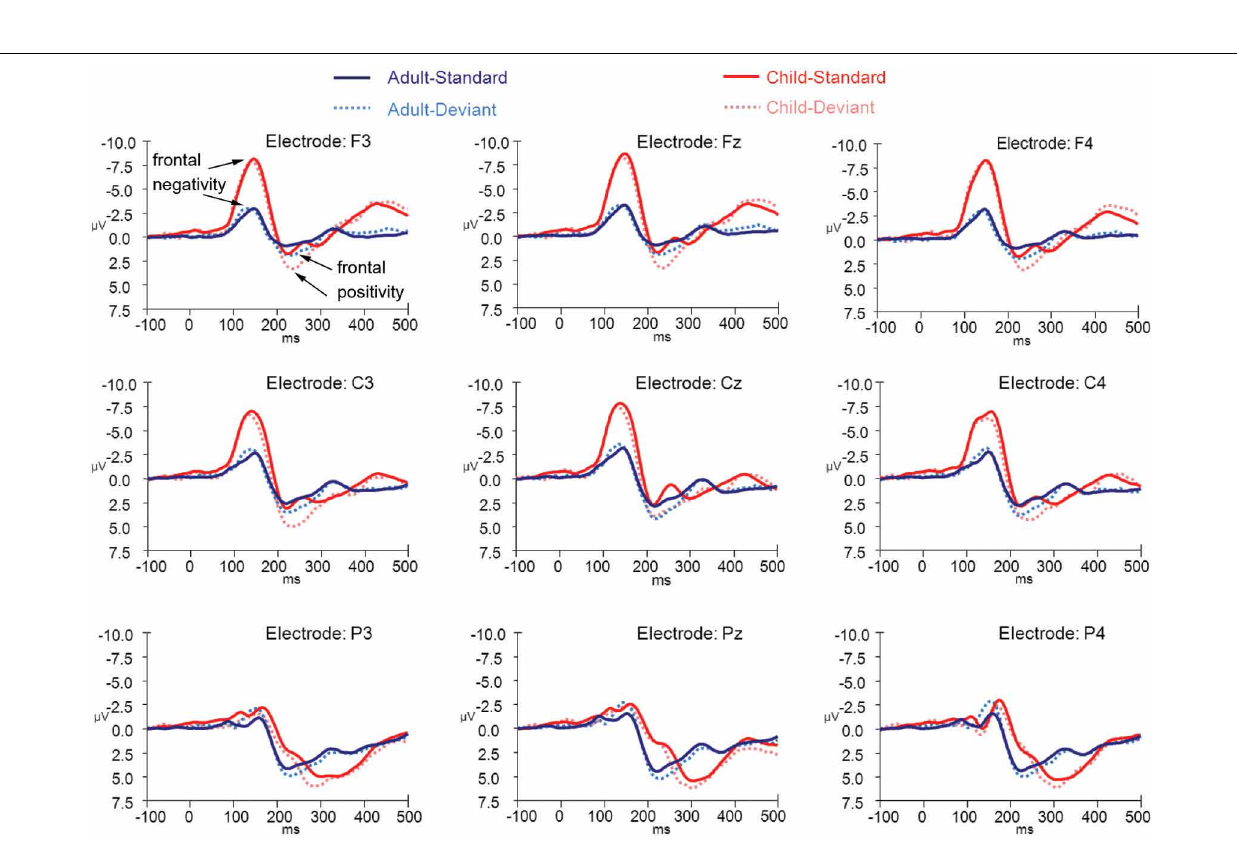
FIGURE 7 | ERPs for both deviant non-target and standard non-target stimulus conditions in children ( N = 21) and adults ( N = 20) at electrode positions F3, Fz, F4, C3, Cz, C4, P3, Pz, and